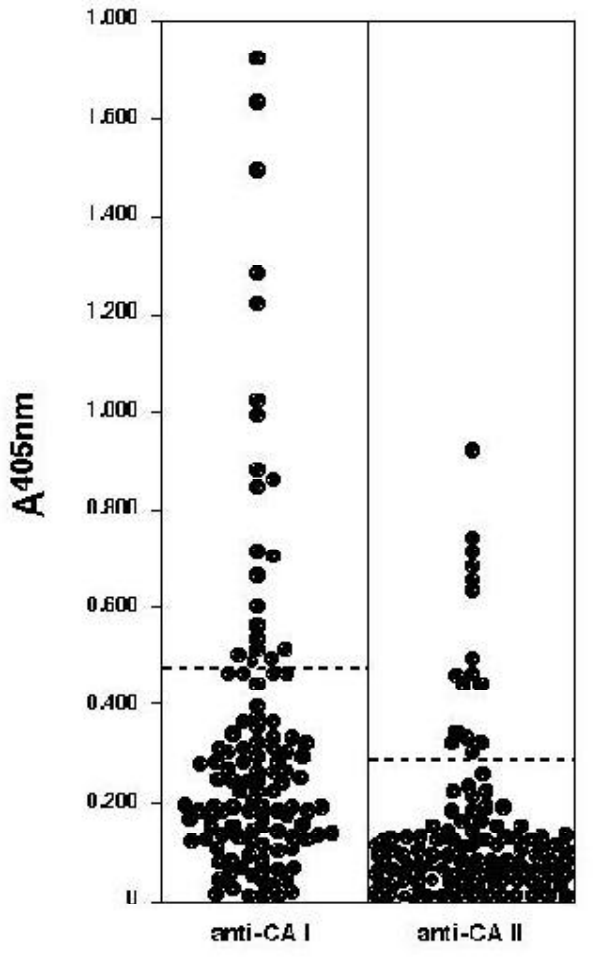
FIGURE 1. Serum levels of anti-CA-I (left) and anti-CA-II (right) Abs CP patients (n = 89). Each black circle represents one patient. Results are expressed as the absorbance lecture at 405 nm. The dotted lines indicate the cut-off values obtained as the result of the mean absorbance +3 SD of HD